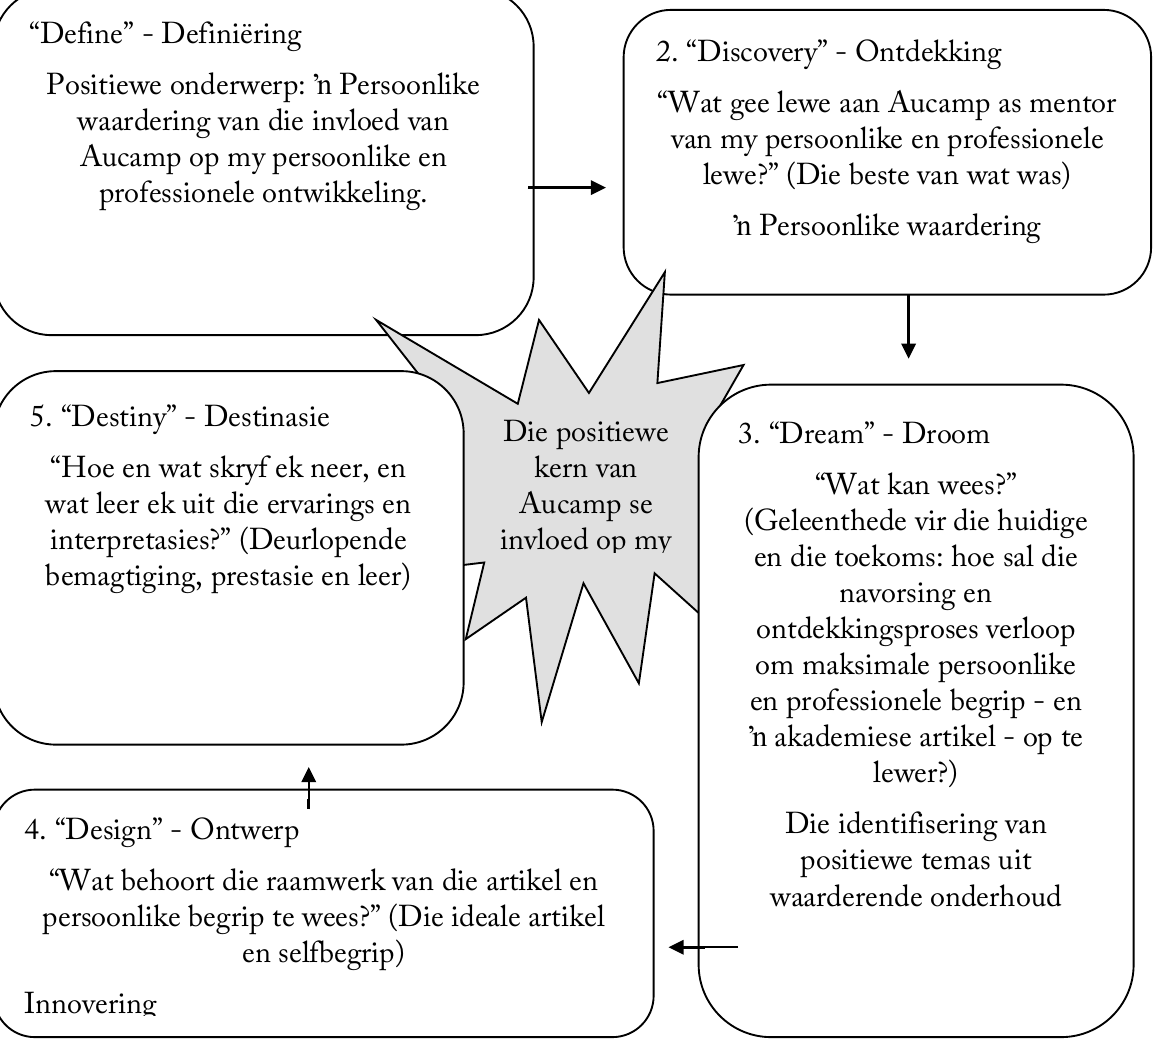
Figuur 1: Die 5D-raamwerk as struktureel-wetenskaplike onderbou vir die studie (soos aangepas uit Whitney & Trosten-Bloom 2010:6 en Pretorius